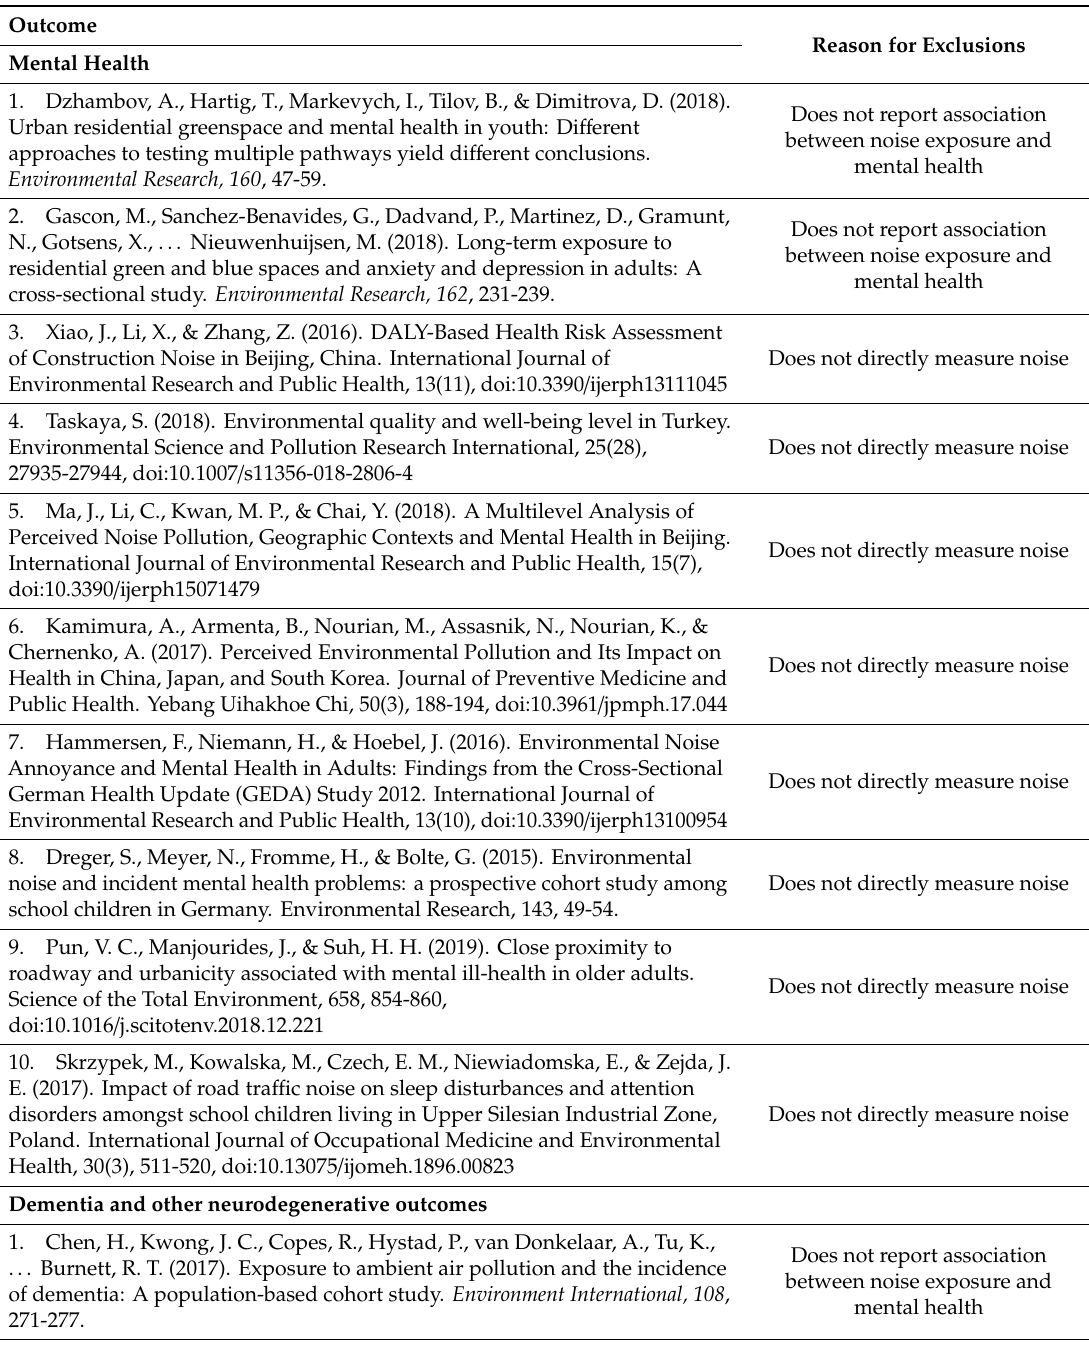
Table A1. Excluded